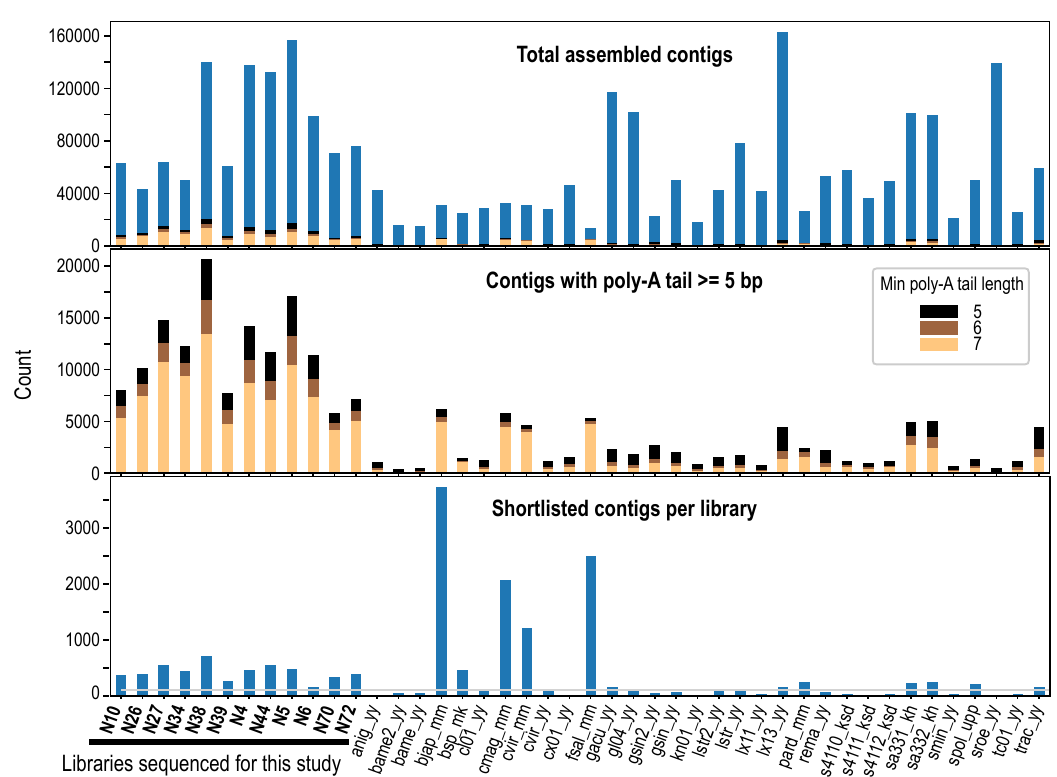
Figure S2 . Number of contigs per transcriptome assembly:(top) total number of contigs, (middle) contigs with poly-A-tails, when different minimum lengths were applied, (bottom) putative full-length transcripts with both a poly-A tail (≥7 bp) and >80% Blastx hit vs. reference Blepharisma stoltei protein sequence (grey horizontal line: 100 sequences cutoff value).